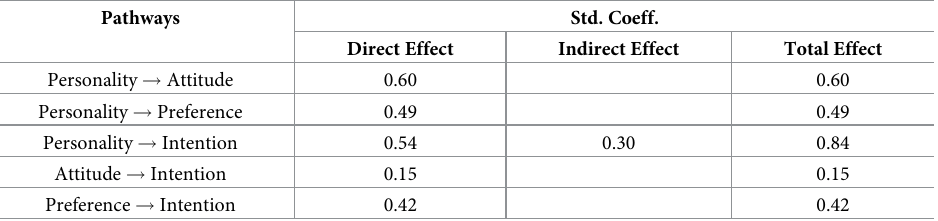
Table 6. Standardized direct, indirect and total effects between latent